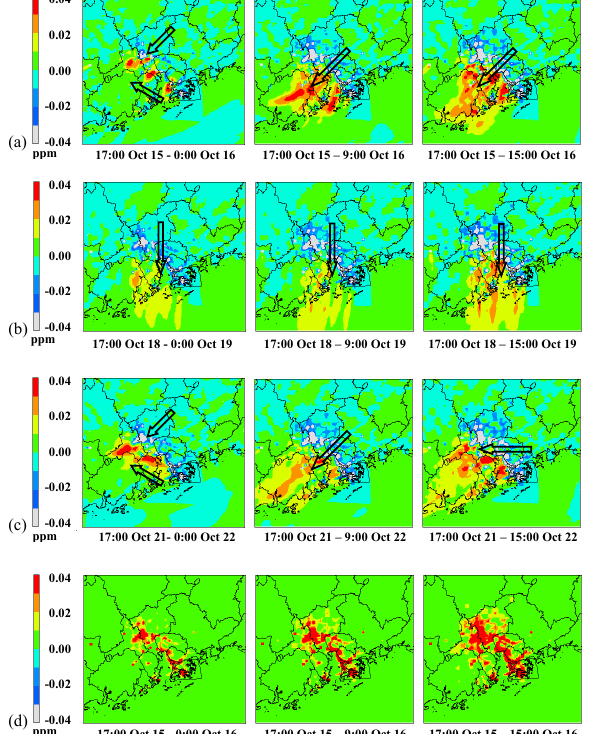
Fig. 12. (a) , (b) and (c) The accumulated contributions to NO x by the transport process over the depth of layers 1 to 7 from 17:00 to 00:00 (left), 09:00 (center), and 15:00LST (right) of the next day. The arrows show the near-ground dominant wind directions during the periods of 17:00–24:00LST (left), 00:00–09:00LST (center), and 09:00–15:00LST (right). (d) The accumulated NO x emissions in the same time range and vertical layers during 15–16 October are shown for comparison.